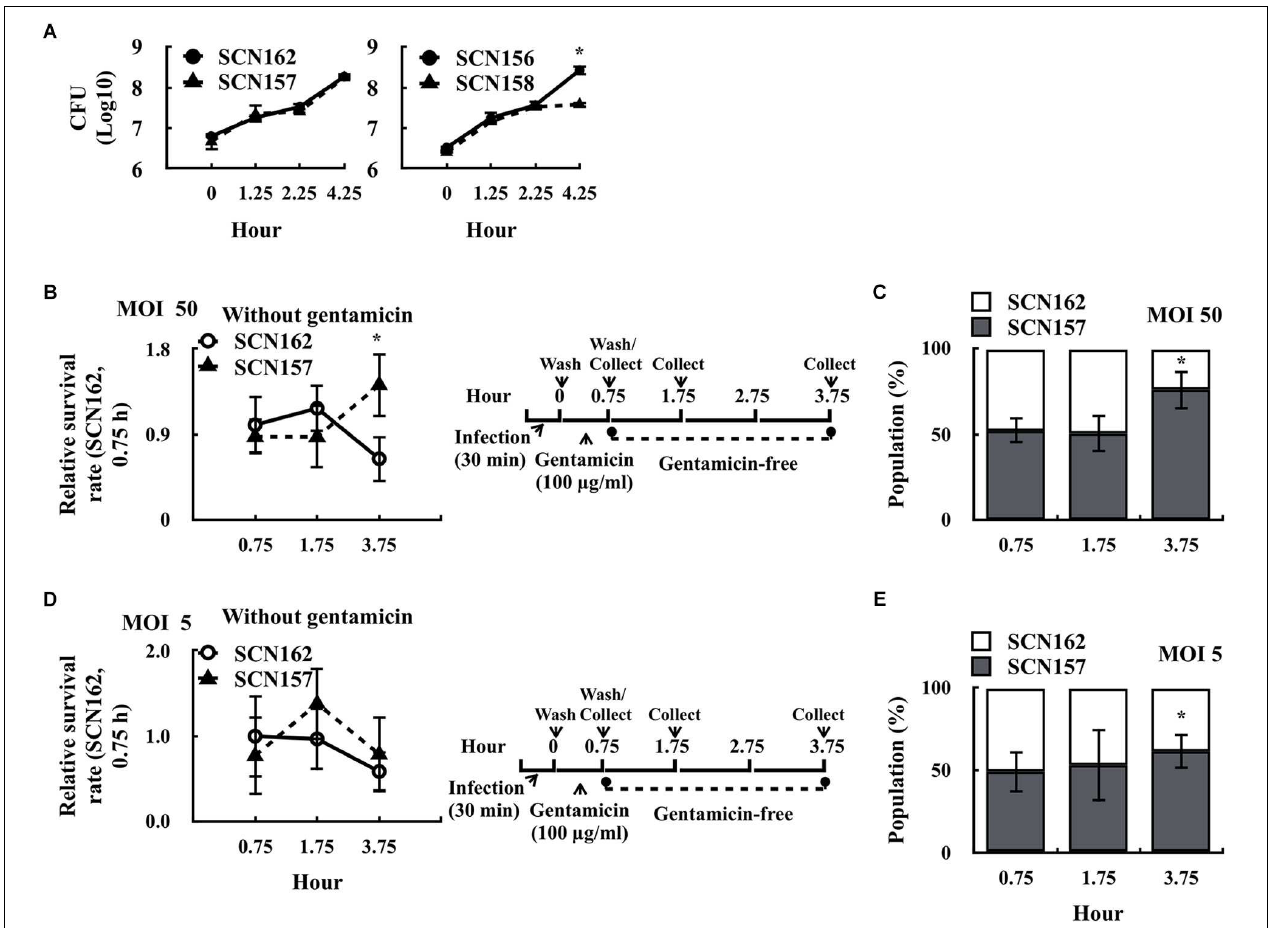
FIGURE 2 | Survival fitness of the capsule-deficient A20 and AP3 in the culture broth and PMA-activated U937 cells. (A) Survival fitness of the capsule-deficient A20 (SCN156 [Cm S ] and SCN162 [Cm R ]) and AP3 (SCN157 [Cm S ] and SCN158 [Cm R ]) in trypticase soy broth with yeast extract (TSBY). An equal number of A20- and AP3-derivative strains was mixed and inoculated in TSBY. After 1.25–4.25 h of incubation, the number of A20 and AP3 mutants was determined using plating method. (B,D) Survival fitness of the capsule-deficient A20 (SCN162 [Cm R ]) and AP3 (SCN157 [Cm S ]) in PMA-activated U937 cells at multiplicity of infection (MOI) of 50 and 5 conditions. PMA-activated U937 cells were infected with mixed SCN162 and SCN157. The infection protocol is shown in the right panel. (C,E) The proportion of SCN157 and SCN162 in the recovered bacterial population after cells were infected with mixed SCN162 and SCN157 at MOI of 50 and 5 conditions. Cm: chloramphenicol. Error bars represent the standard deviations. ∗ p <